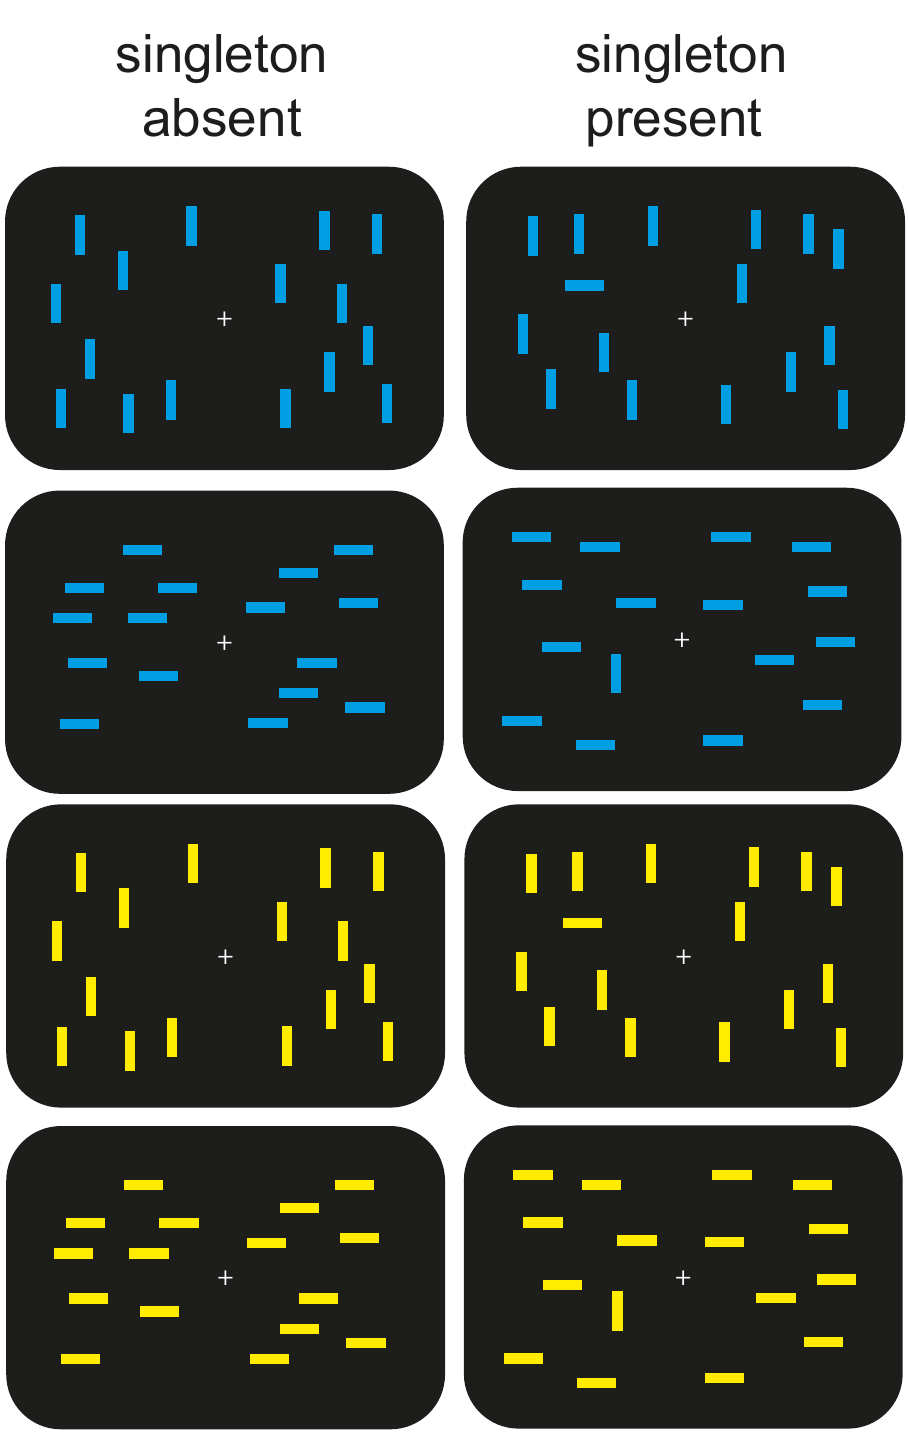
Fig 1. Example stimulus displays used in Experiments 1 and